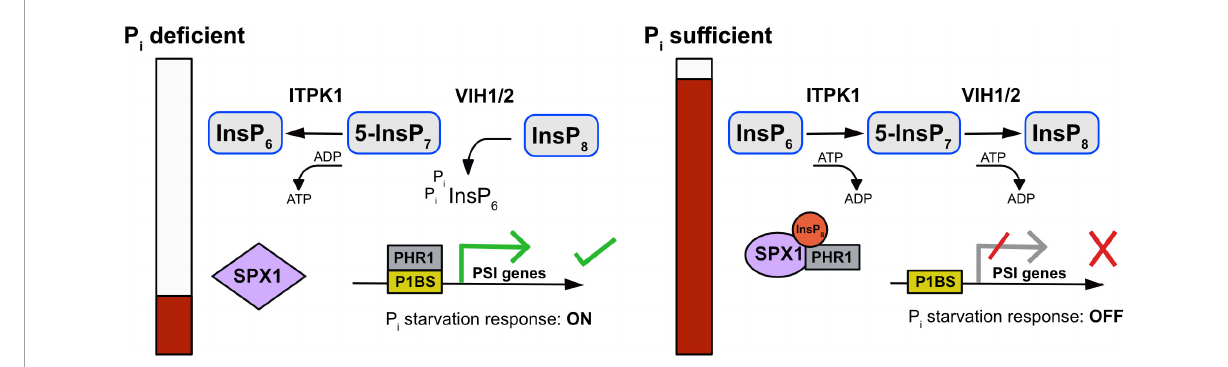
FIGURE2 Model for the ITPK1-dependent phosphorylation of InsP6 and 5-InsP7 removal and possible link of ITPK1 with VIHs and phosphate homeostasis. Upon Pi-deficiency, ATP levels drop and stimulate ITPK1 to transfer the P-phosphate from 5-InsP7 to ADP, leading to the local generation of ATP and decreased 5-InsP7 levels. Additionally, low ATP/ADP ratios (i.e., low adenylate charge) and low Pi levels cause the switch from kinase to phosphatase activity of VIH proteins to hydrolyze InsP8. Lacking PP-InsPs, the interaction between PHR1 and SPX1 is destabilized, which promotes the binding of PHR1 to the P1BS motif in the promoter region of PSI genes. As a result, the Pi starvation response is activated. When plant cells regain sufficient Pi, ATP levels increase and the kinase activity of ITPK1 is activated, leading to the generation of 5-InsP7, which further serves as substrate for the kinase-activated VIH proteins to produce InsP8. Consequently, the accumulation of PP-InsPs facilitates the binding of SPX proteins to PHR1 to suppress Pi starvation